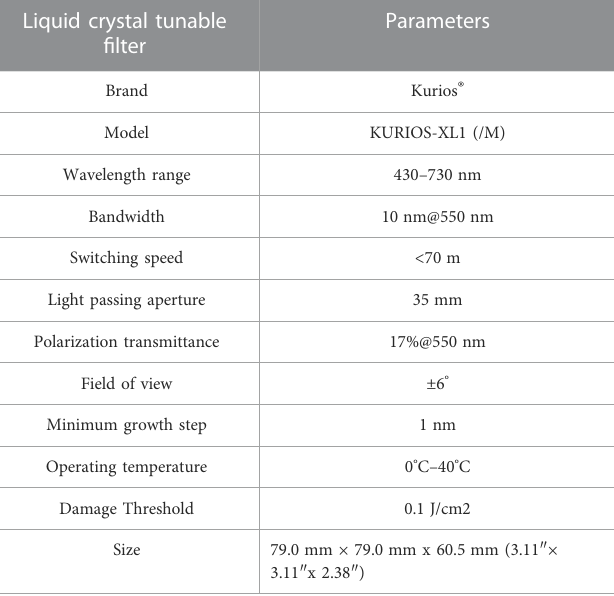
TABLE 3 Liquid crystal variable retarder parameters. Liquid crystal variable retarder